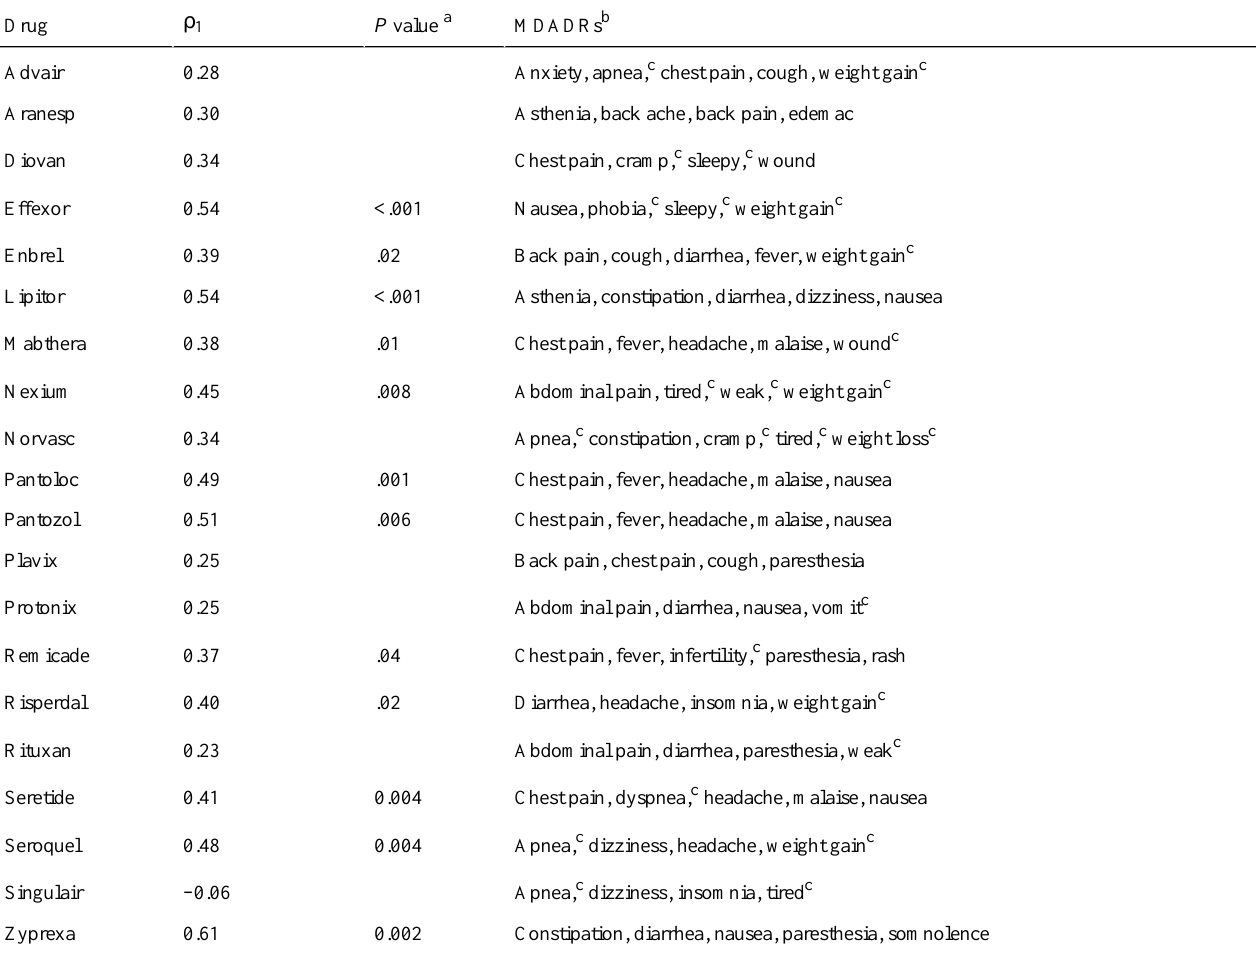
Table 2. Spearman rank correlation ( ρ ) between query log reaction score (QLRS) and the number of adverse drug reaction (ADR) reports in the Adverse Event Reporting System (AERS), with the most discordant ADRs (MDADRs) removed.